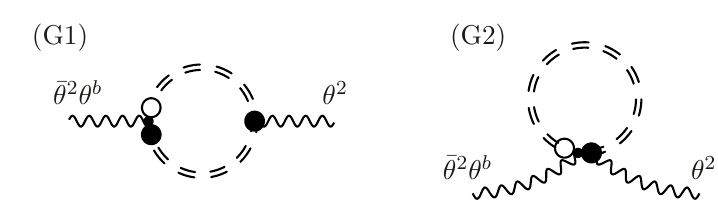
Figure 2 . Effective superdiagrams giving the contribution of the Faddeev-Popov ghosts to the β